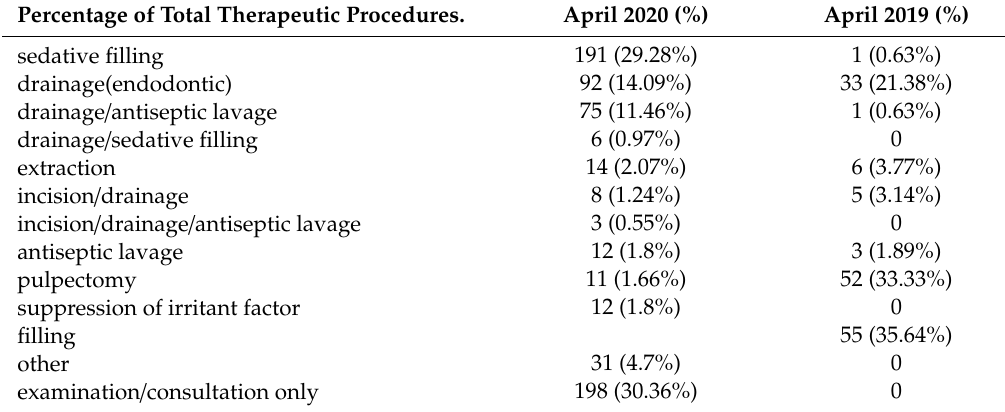
Table 4. Comparison of the treatment of common oral emergencies during April 2019 and April 2020. Percentage of Total Therapeutic